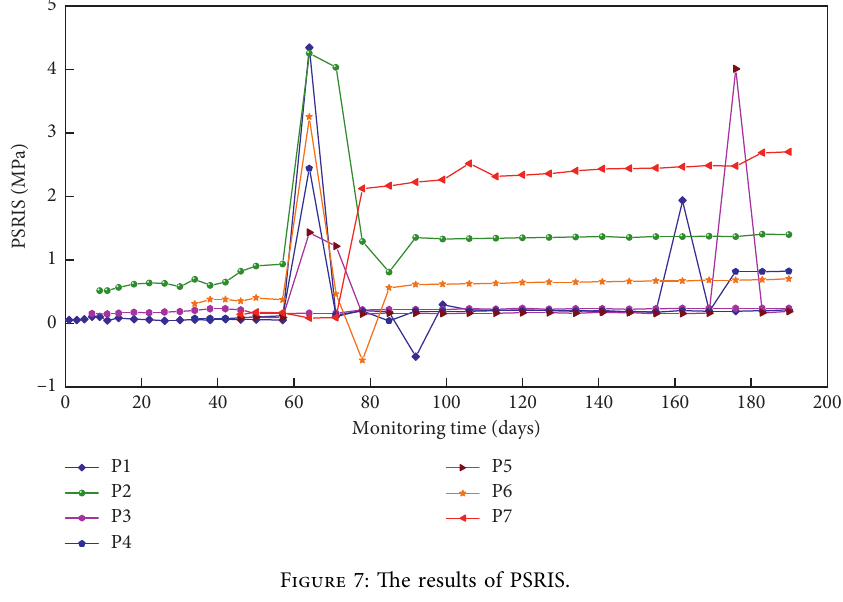
Figure 7: The results of